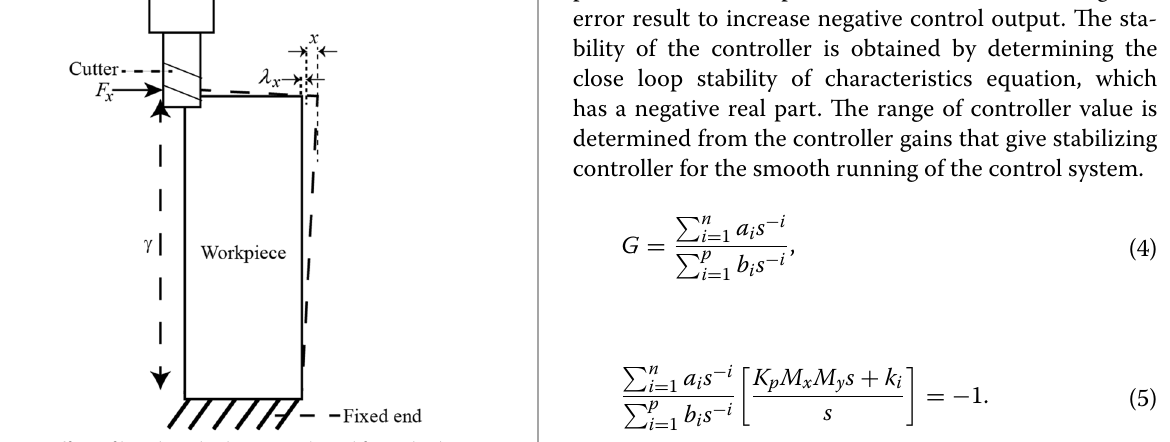
Figure 1 Effect of bending displacement (cid:31) x and force displacement x . Here, γ is the perpendicular distance between applied force and a support